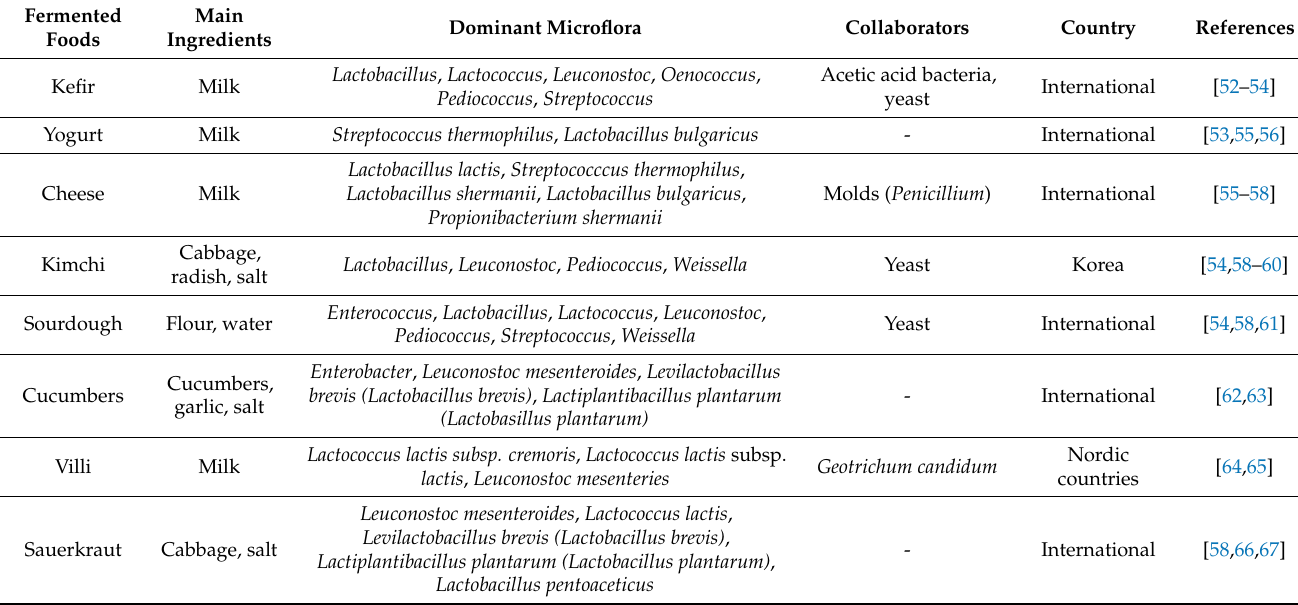
Table 2. Characteristic products obtained through lactic fermentation, listing dominant and collabo- rating